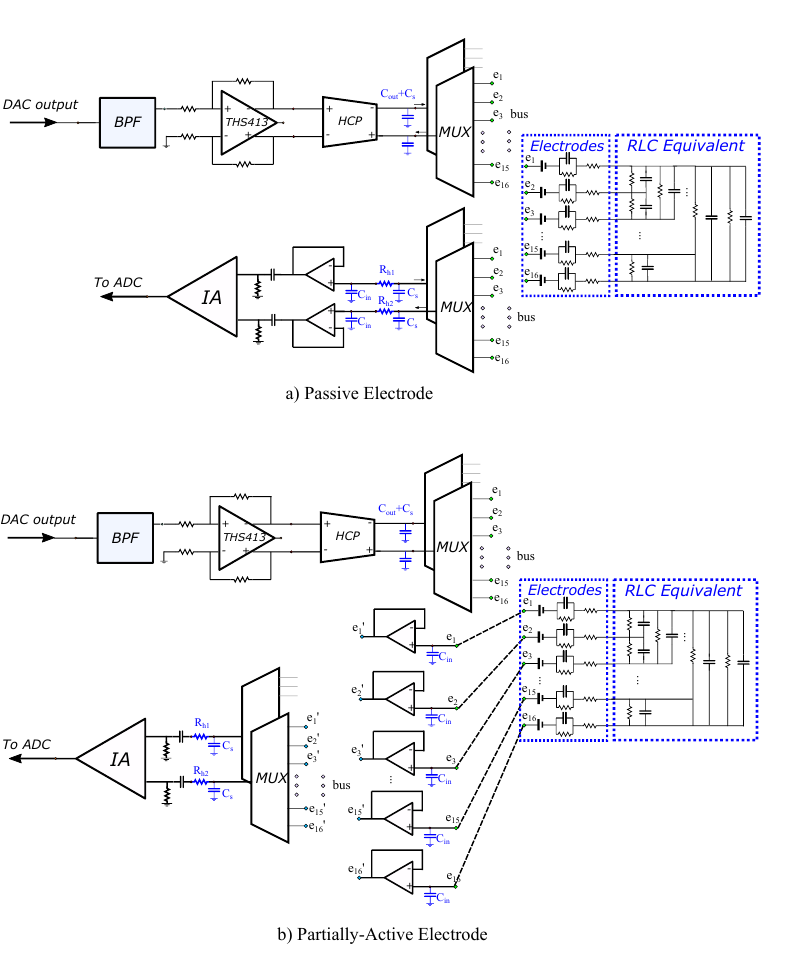
Figure 4. LT SPICE analogue circuitry configurations for ( a ) passive electrodes (cables and switches between the readout front-end circuit and the electrode) and ( b ) partially active electrodes (the first stage of the readout circuit is implemented directly on each particular electrode). Blue-coloured components indicate the parasitic capacitors and channel resistors added to simulate their